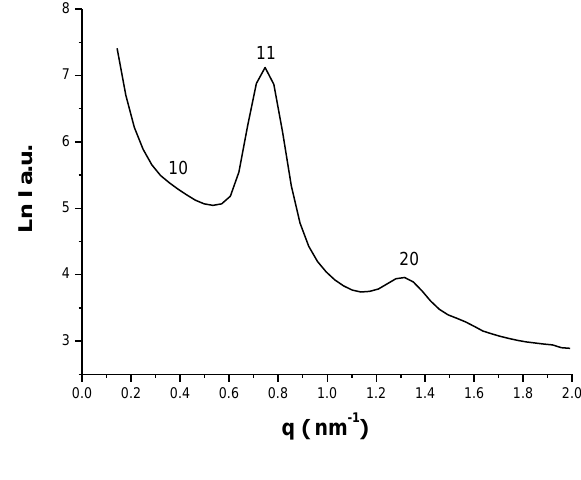
Figure 2. SASX patterns of the mesoporous carbon